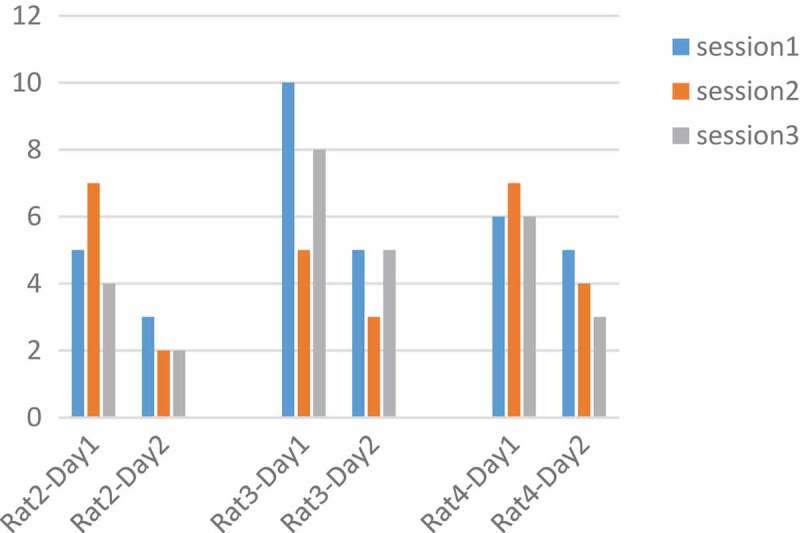
Performance of rats at 260 µs.